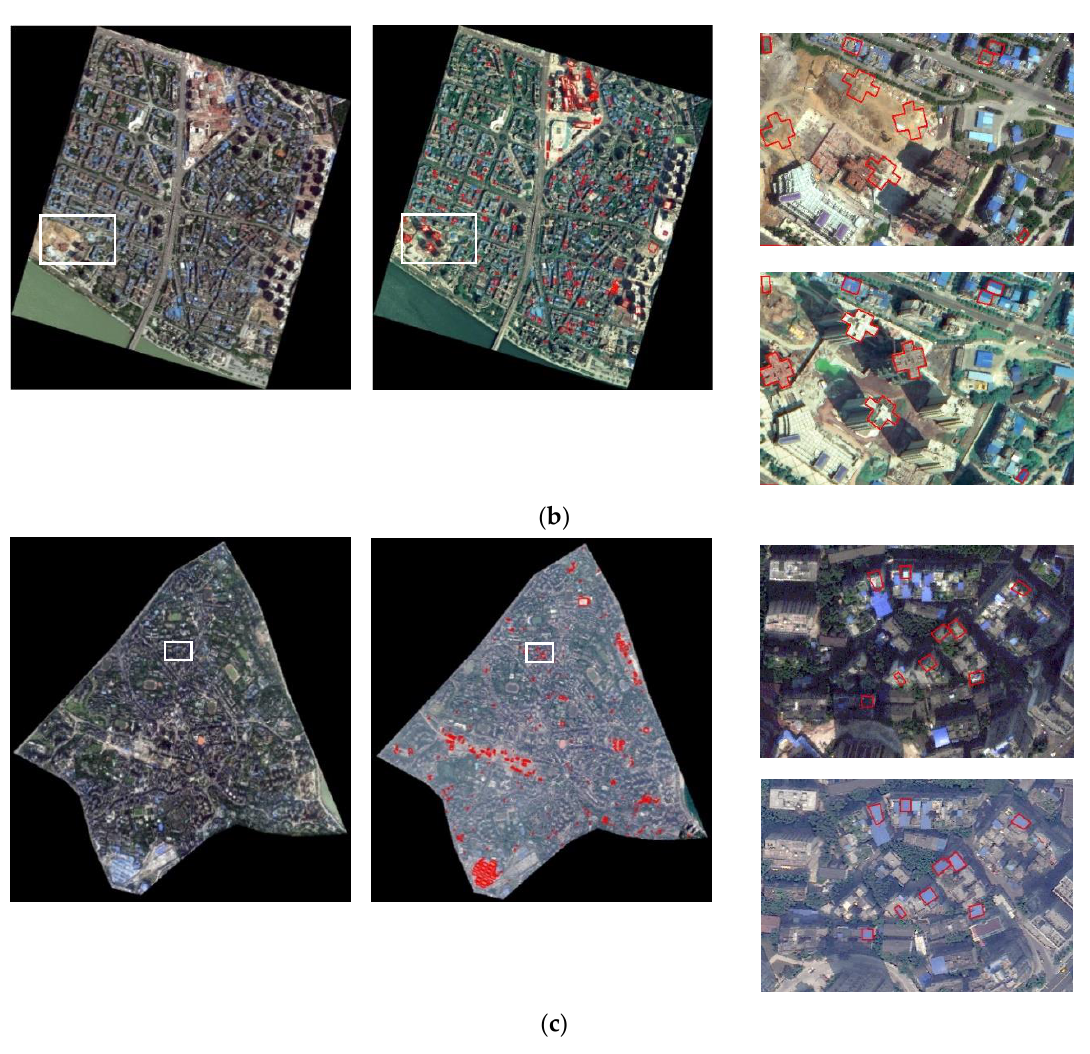
Figure 2. The images in dataset DI and dataset DII. In ( a ), the first two rows show the two scenes in the same area. In ( b , c ), the first two columns show the two scenes in the same area. The changed buildings are marked with a red polygon in the right images. The last column is the zoomed-in view of area selected by the white box.